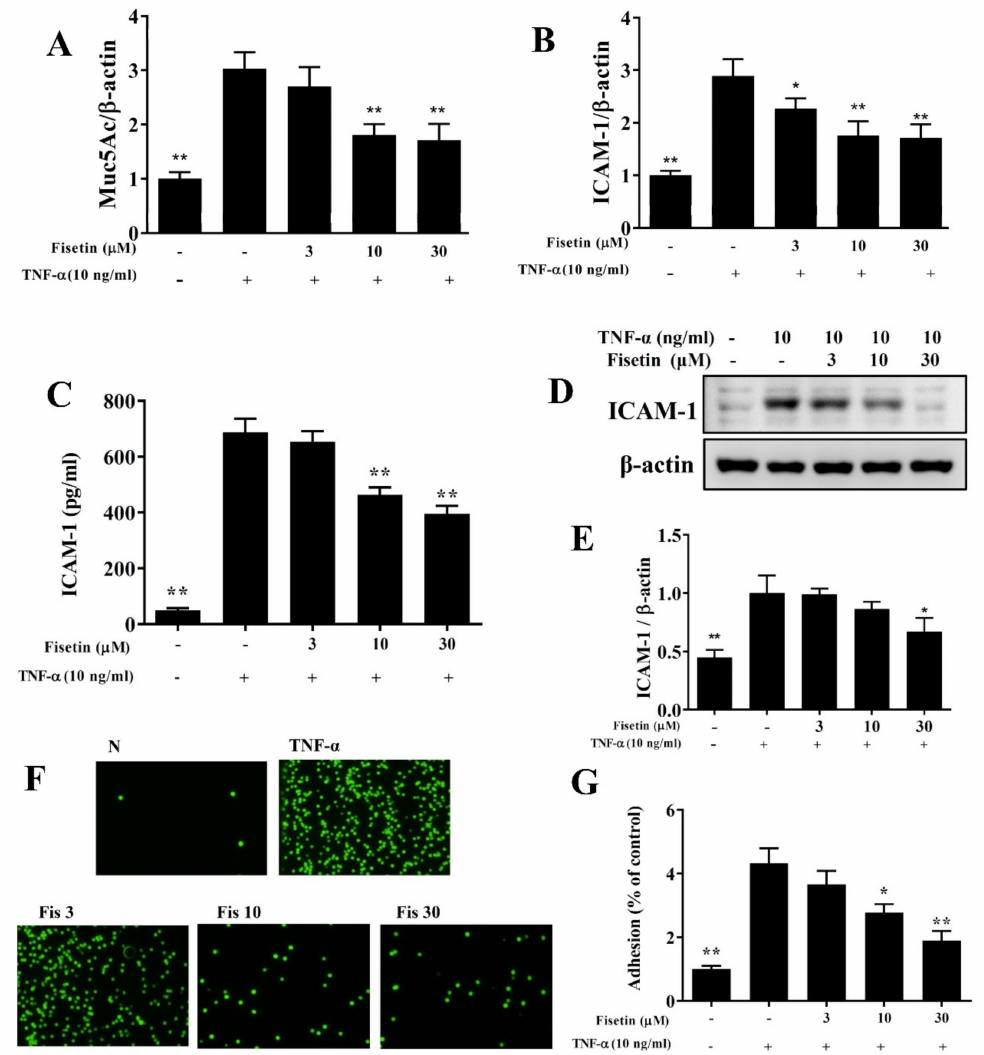
Figure 3. MUC5AC and ICAM-1 expression suppressed by treatment with fisetin (Fis) in TNF- α -induced BEAS-2B cells. ( A ) MUC5AC and ( B ) ICAM-1 gene expression detected by real-time PCR. The fold expression presented relative to β -actin expression ( n = 8 per group). ( C ) ELISA ( n = 12 per group) and ( D ) Western blot investigated ICAM-1 expression ( n = 3 per group). ( E ) The fold expression relative to β -actin. ( F ) THP-1 cells (fluorescently labeled green) co-cultured with unstimulated (N) or TNF- α -stimulated BEAS-2B cells treated with Fis. ( G ) Percentage of THP-1 cell adhesion to BEAS-2B cells. The data presented as mean ± SEM of three independent experiments. * p < 0.05, ** p < 0.01, compared to the TNF- α -stimulated BEAS-2B cell